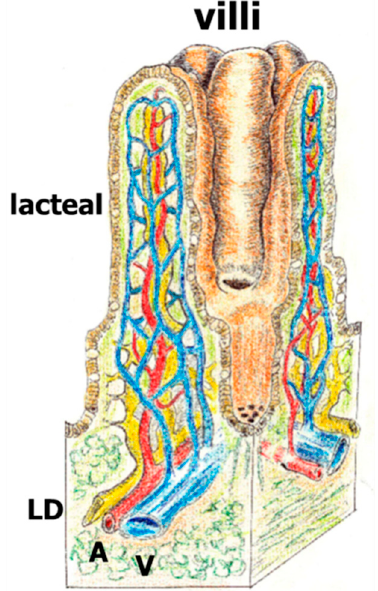
Figure 3. Draft of the intestinal villi with lymphatic lacteal and lymphatic ducts (LC: yellow), artery (A: red) and vein (V: blue). (A: red) and vein (V: